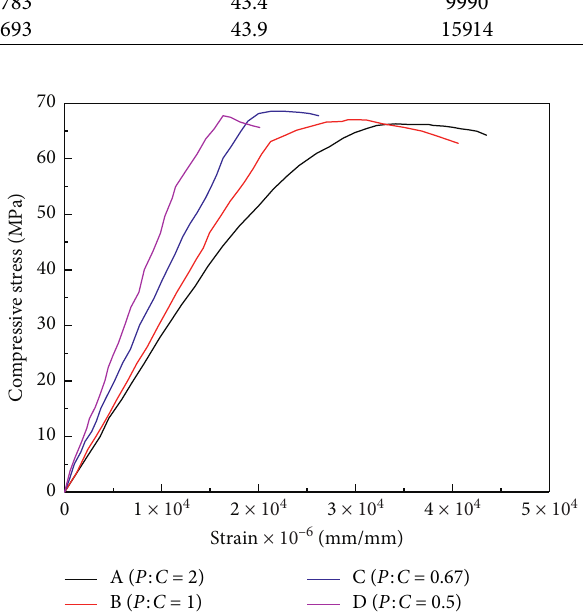
Figure 7: Compressive stress-strain curves of polyurethane